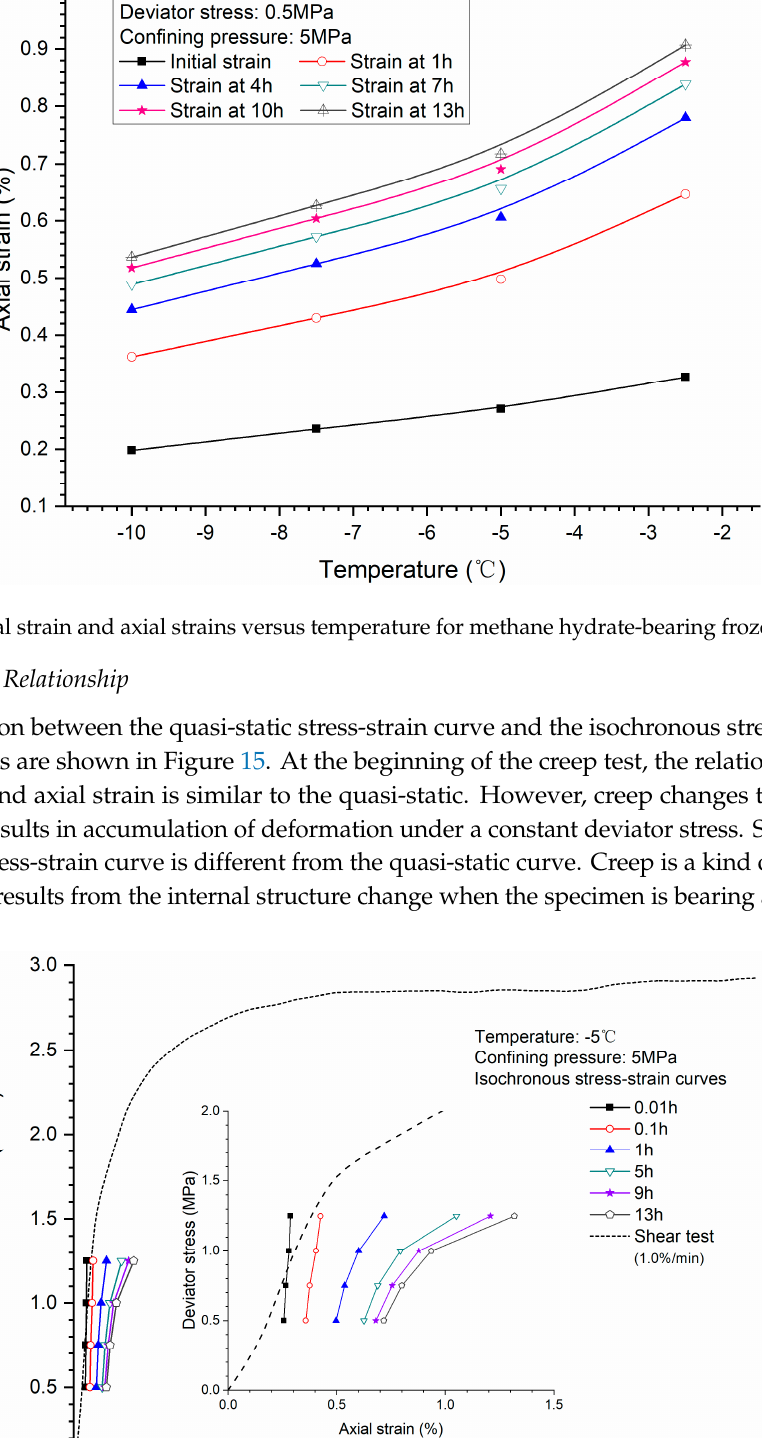
Figure 13. Creep strain rate versus axial strain for methane hydrate-bearing frozen specimens under various temperatures.